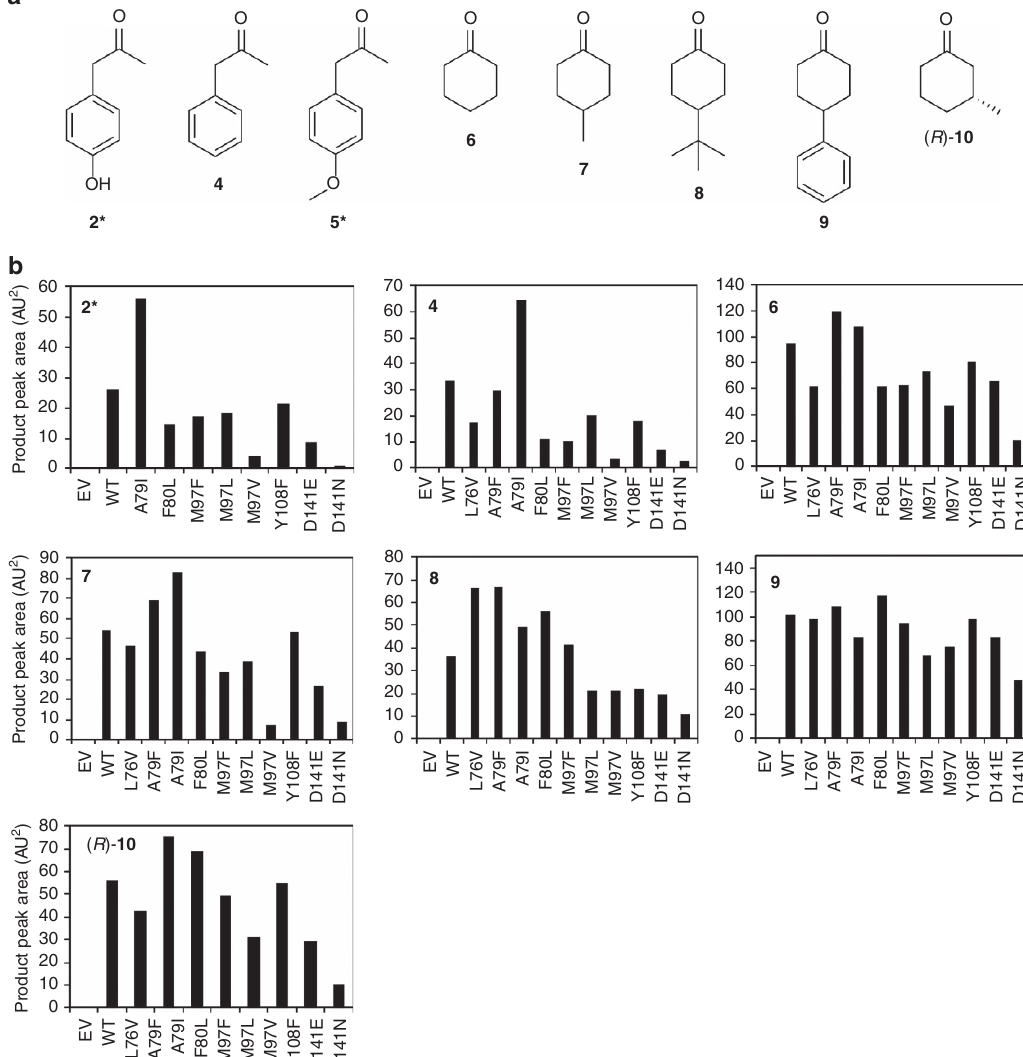
Figure 4 | Ketones screened with D 29 Tf NCS variants. ( a ) Structures of ketones tested that showed conversion by D 29 Tf NCS variants. Ketones accepted: 4-hydroxyphenylacetone 2 *, phenylacetone 4 , 4-methoxyphenylacetone 5 *, cyclohexanone 6 , 4-methylcyclohexanone 7 , 4- tert -butylcyclohexanone 8 , 4-phenylcyclohexanone 9 and (3 R )-methylcyclohexanone ( R )- 10 . ( b ) Charts showing HPLC product peak area in reactions with dopamine, different ketones and different D 29 Tf NCS variants (EV, empty vector control). See Supplementary Fig. 3 for representative HPLC chromatograms and Supplementary Fig. 4 for structures of ketones not accepted by any D 29 Tf NCS variant. *Commercially available ketone 2 (4-hydroxyphenylacetone) was tested in the initial screen but degradation of the ketone starting material restricted its suitability for use in scale up reactions. Therefore, the more stable ketone 5 (4-methoxy-phenylacetone) replaced ketone 2 in the scale up biotransformations (Fig.